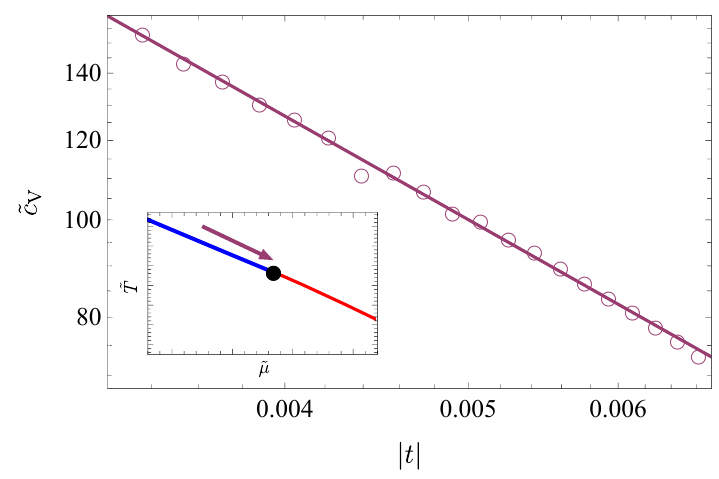
Figure 7 . The plot shows the critical behavior of the specific heat along the triple line in log scale. The open circles and the solid line denote the numerical data and the fitting result, respectively. The inset shows the phase diagram, and the arrow denotes the path along the triple line.